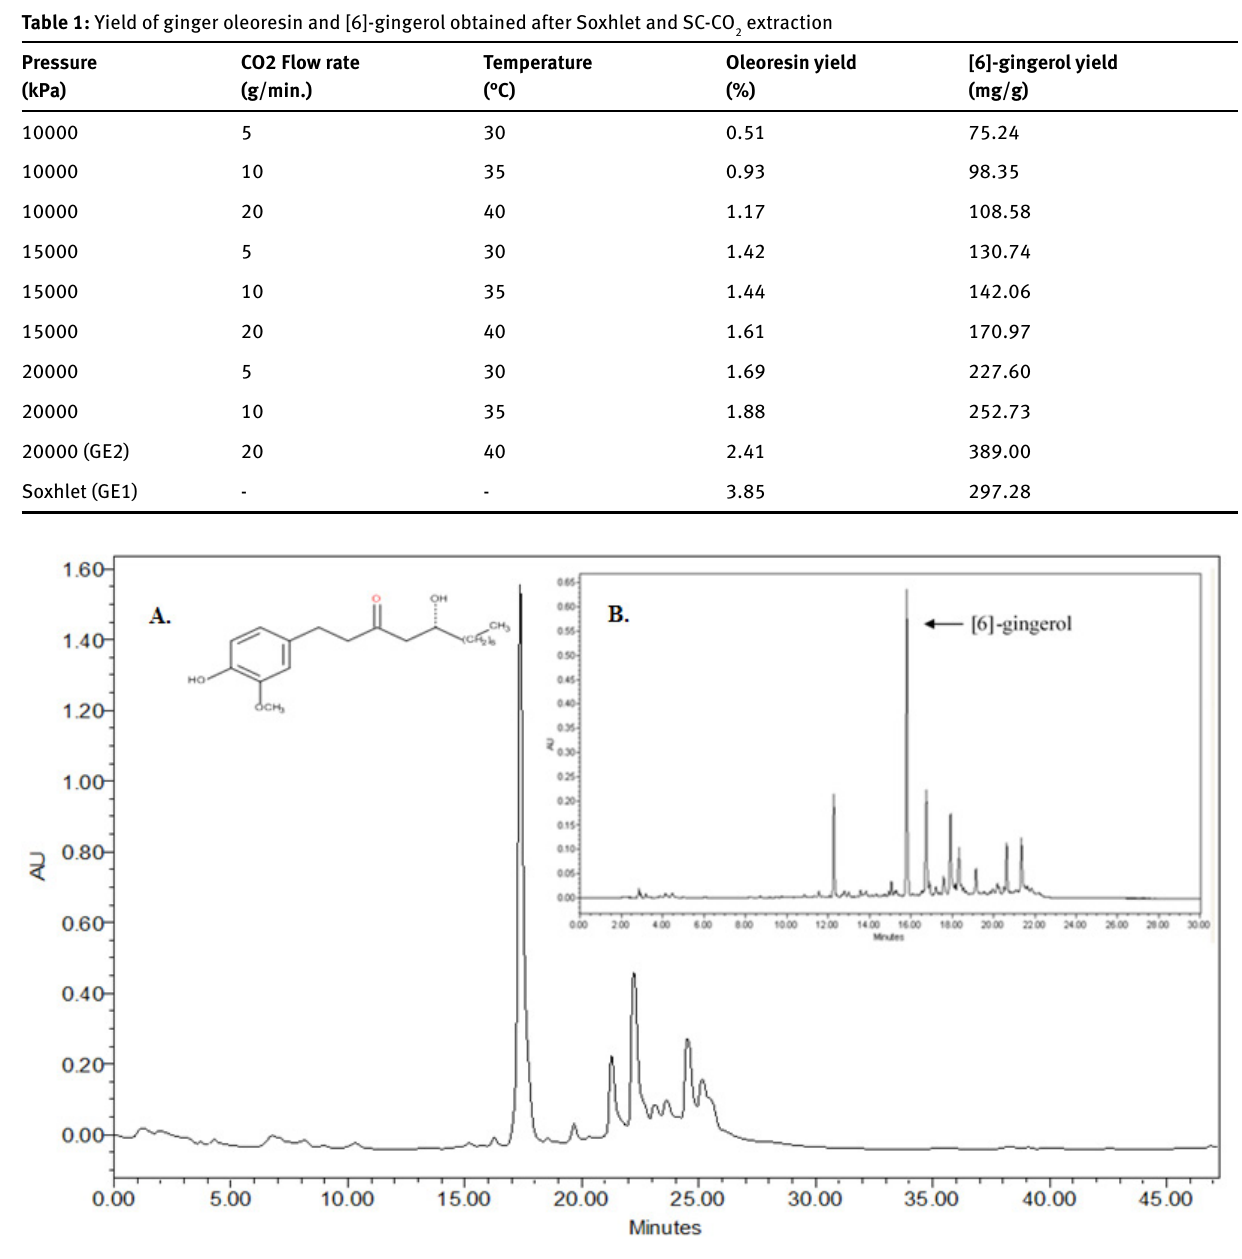
Figure 2: HPLC chromatogram for [6]-gingerol (A) [6]-gingerol standard (B) Ginger extract